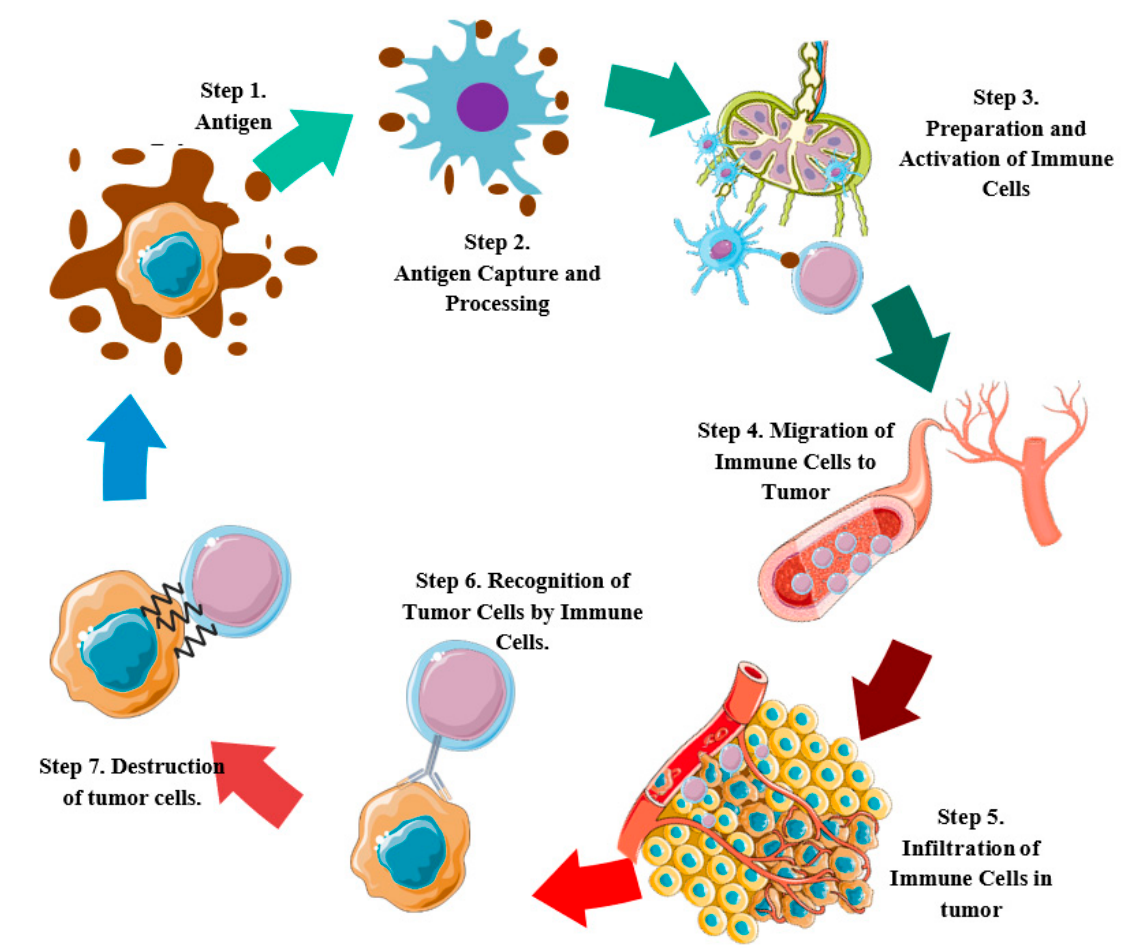
Figure 1. Main processes of the antitumor cellular adaptive immune response system. Step 1, release of antigens by the death of tumor cells. Step 2, recognition and antigen processing. Step 3, priming and activation of T-cells by antigen-presenting cells. Step 4, T-cell migration. Step 5, T-cell infiltration into tumor tissue. Step 6, recognition of tumor cells by T-cells. Step 7, destruction of tumor cells by T-cells.